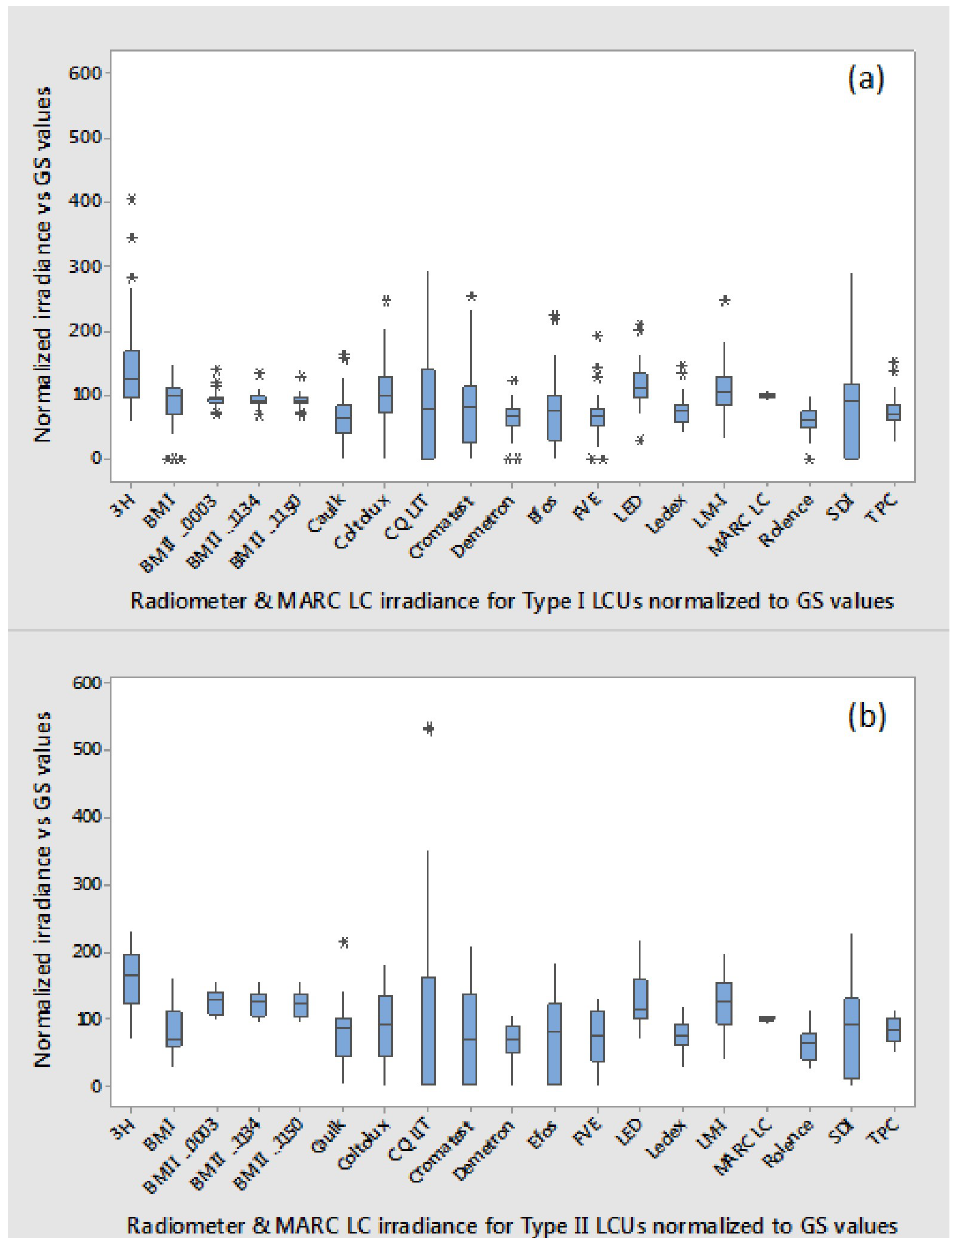
Fig 4. Normalized pooled mean irradiance for all LCUs; (a) Type I and (b) Type II tested with the sixteen models of dental radiometers—the 3 examples of the BM II are denoted by the last 4 digits of their respective serial numbers ... 0003, ... 1134, ... 1150 and the MARC LC instrument (calculated from mean power data) relative to the gold standard Integrating Sphere method. Note the extremely wide data spread for many